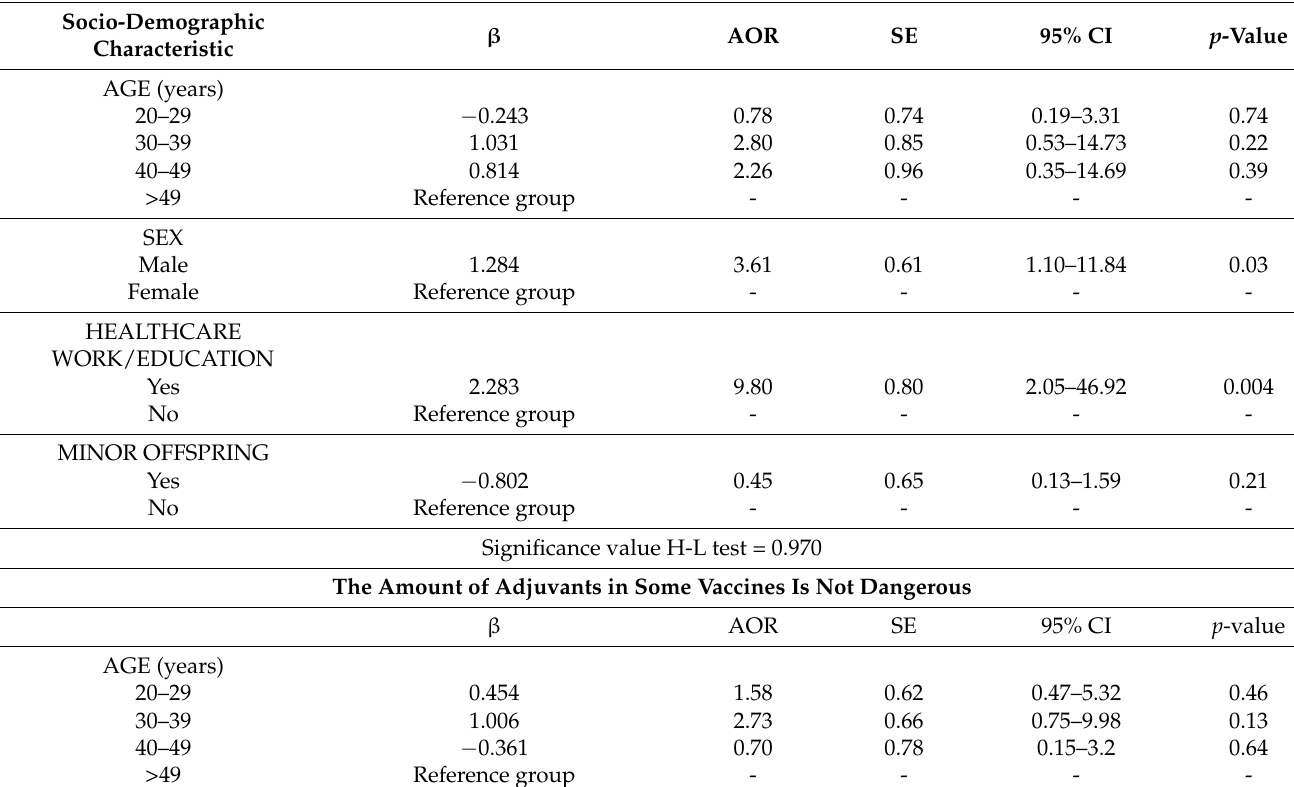
Table 5. Multivariate logistic regression analysis perfomed on Section 3 of questionnaire. Note— β : regression coefficient. AOR: adjusted odds